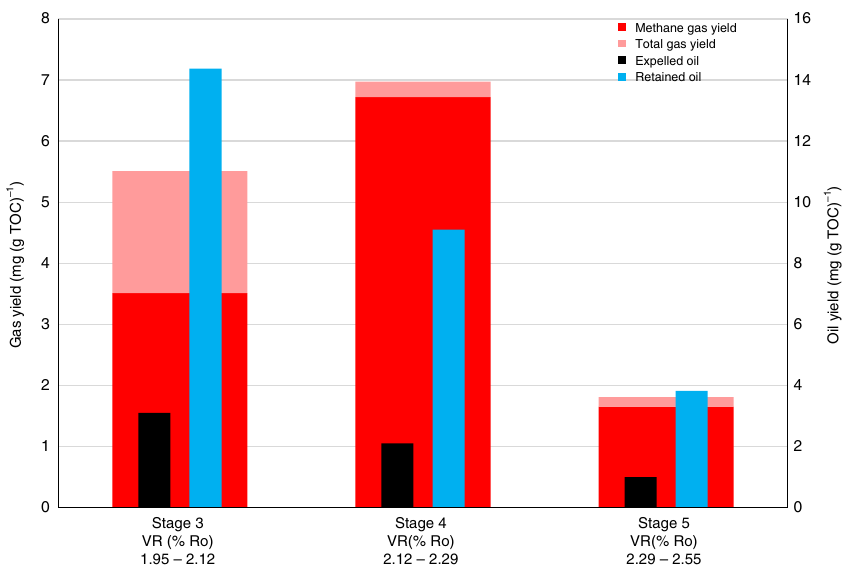
Fig. 3 Total hydrocarbon gas (C 1 – C 5 ), methane, expelled oil and retained oil/bitumen yields (mg/g TOC of rock at the end of each stage) for the sequential HPWP experiment on the Grange Hill core sample at 300 bar. The VR % (Ro) values below each histogram are for the start and end of each stage. The differences in the measured values from duplicate tests are generally within 6% for gas (C 1 – C 5 hydrocarbons) yields, 4% for expelled and retained oil yields and 2% for gas a narrower neck empties, indicating possible ink-bottle pores from the hysteresis in the desorption branch. MIP indicates that the dry porosity is only 1.1% for the initial shale (Supplementary Table 4, multiplying 0.0042 cm 3 g − 1 by the skeletal density of 2.689 g cm − 3 from helium pycnometry). However, this low value could be partially attributable to the drilling mud present. After HPWP, the dry porosity increases to ca. 7% but, with a moisture content of ca. 2% w/w, corresponding to ca. 5% by volume, means that the wet porosity will be close to 1%. and size distributions listed in the Supplementary Table 6. The